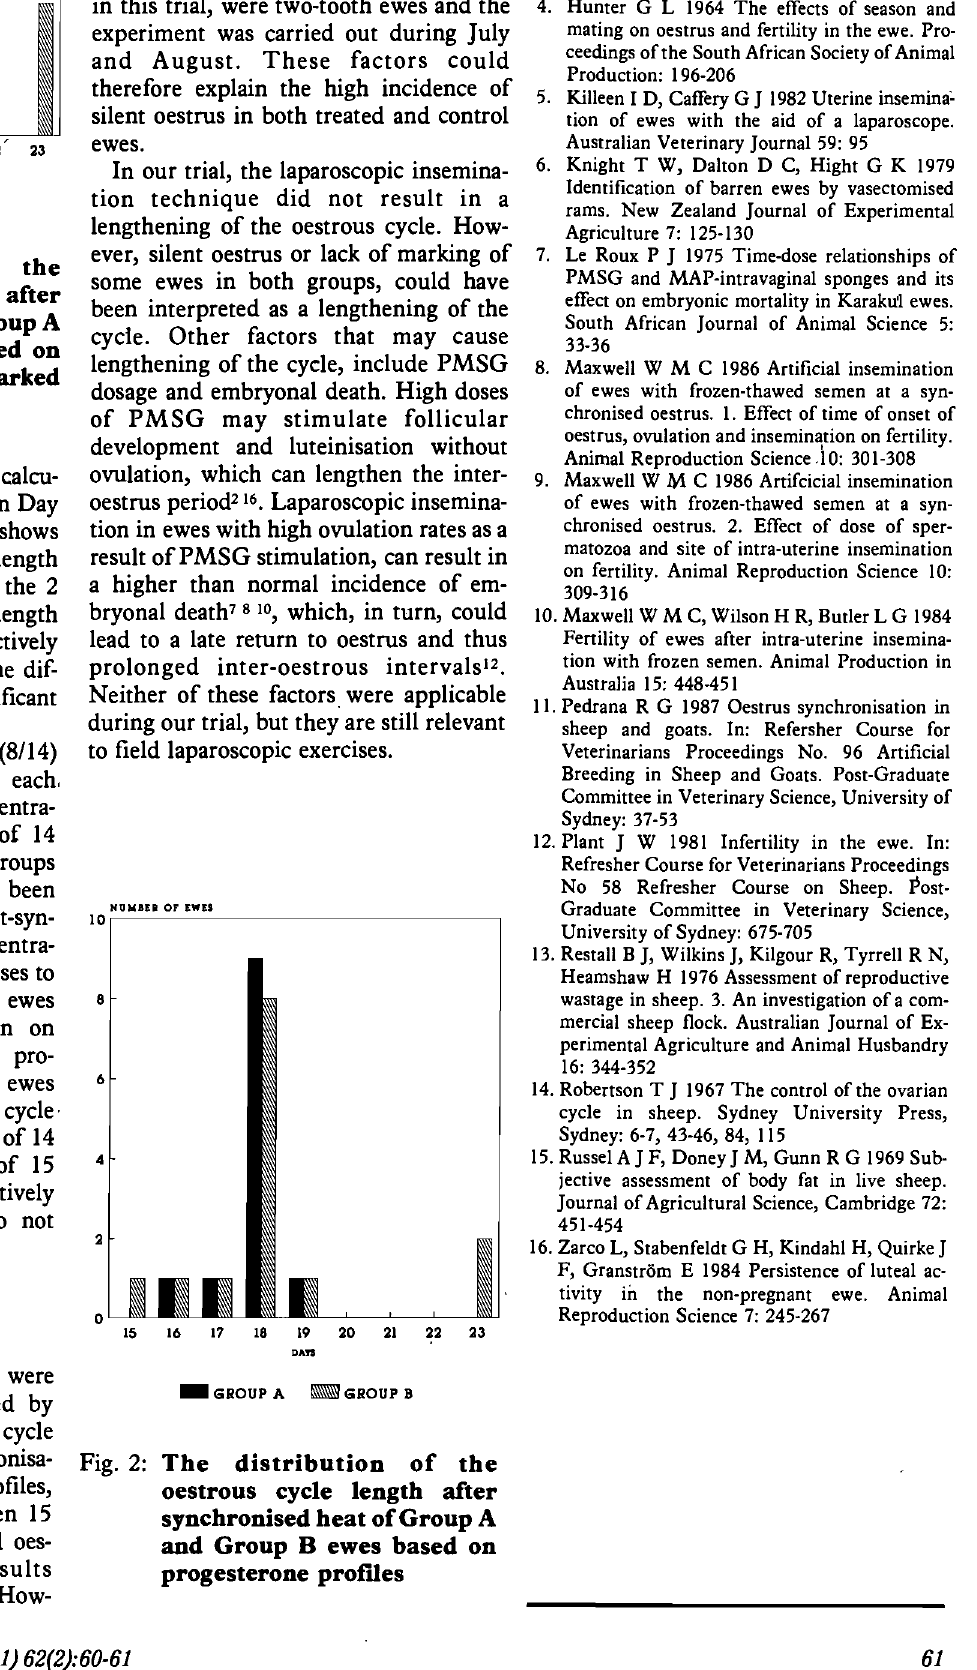
Fig. 1: The distribution of the oestrous cycle length after synchronised heat of Group A and Group B ewes based on the number of ewes marked by the teaser rams